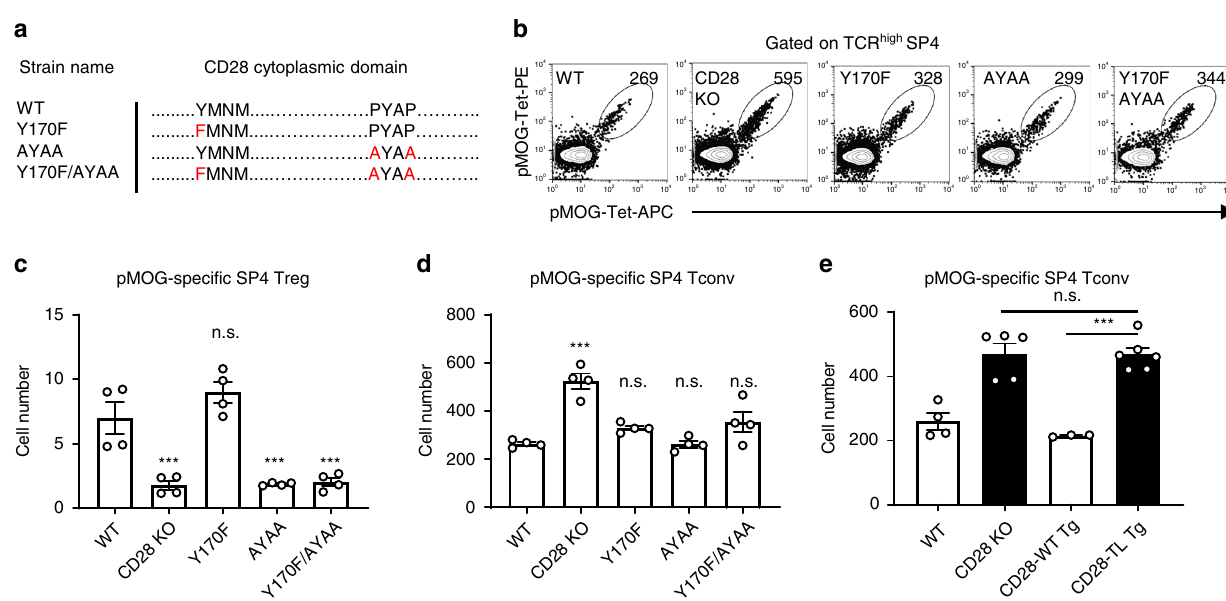
Fig. 5 Clonal deletion and Treg cell generation require distinct CD28 cytoplasmic motifs. a Amino acid substitution in each CD28 mutant mouse. b pMOG-speci fi c SP4 thymocytes of each CD28 mutant strain. c pMOG-speci fi c SP4 Treg (Foxp3 + ) thymocyte number in CD28 mutant strains. Each group n = 4. Data shown are combined results of three independent experiments. CD28 KO p = 0.0004, AYAA p = 0.0004, Y170F/AYAA p = 0.0006. d pMOG-speci fi c CD4SP Tconv (Foxp3 − ) thymocyte number in CD28 mutant mice. Each group n = 4. Data shown are combined results of three independent experiments. CD28 KO p < 0.0001. e pMOG-speci fi c SP4 Tconv number in CD28-TL (Tail-Less) Tg and CD28-WT Tg mice. WT n = 4, CD28 KO n = 5, CD28-WT Tg = 3, CD28-TL Tg n = 6. Data were pooled from three independent experiments. CD28 WT Tg and CD28-TL Tg p = 0.0001. c – e Data ar e mean ± SEM with dots representing individual values of biologically independent animals. Statistical differences between groups were performed with One-way ANOVA followed by Dunnett ’ s multiple comparison. * p < 0.05, ** p < 0.01. n.s.; not signi fi cant ( p > 0.05). Source data are provided as a Source Data fi